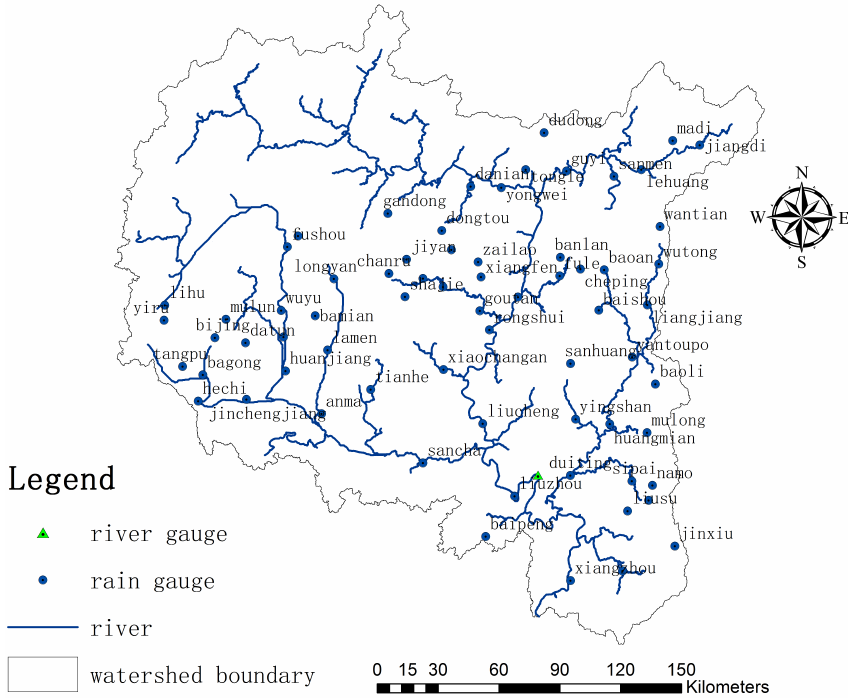
Figure 1. Sketch map of the Liujiang River basin (Chen et al.,